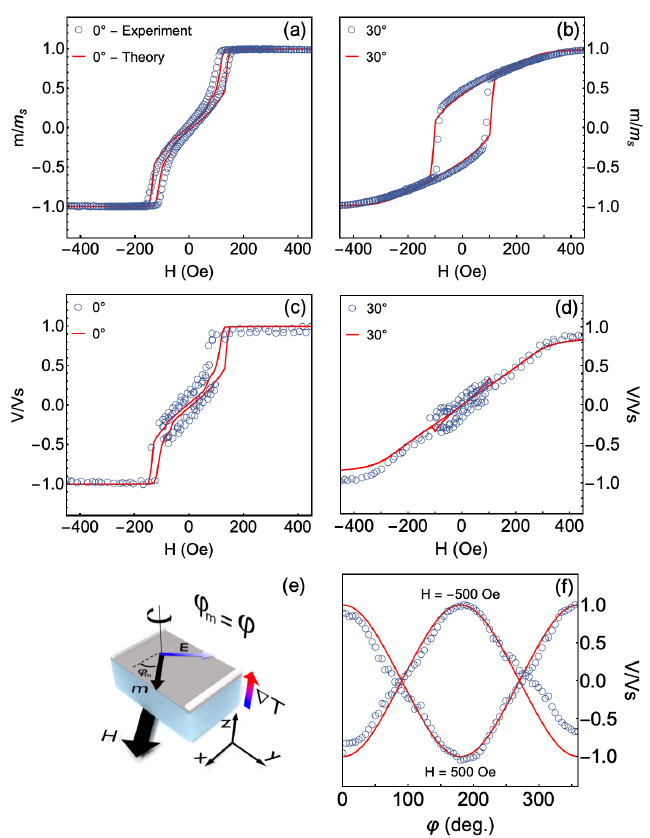
Figure 7. Comparison between theory and experiment: Normalized magnetization curves, at ( a ) ϕ = 0 ◦ and ( b ) 30 ◦ , for the CFA/W bilayer in which the CFA layer was grown at 573 K. ( c , d ) Corresponding normalized thermoelectric voltage curves. ( e ) Schematic representation of our bilayer structure in the experiment, in which we depict ϕ m that is inserted in Equation (9) for the calculations. ( f ) Normalized curves of the angular dependence of the thermoelectric voltage, at ∆ T = 27 K, for H = ± 500 Oe. In particular, the calculations here were performed system with uniaxial anisotropy dispersion, with m si = m s 1 = ... = m s 50 = m s = 1330 G, k ui = k u 1 = ... = k u 50 = k u , where h k = 220 Oe and ϕ ki is dispersed linearly around 0 ◦ , with dispersion range of ∆ ϕ k = 10 ◦ , as well as k c 1 i = k c 11 = ... = k c 150 = 2.8 k u